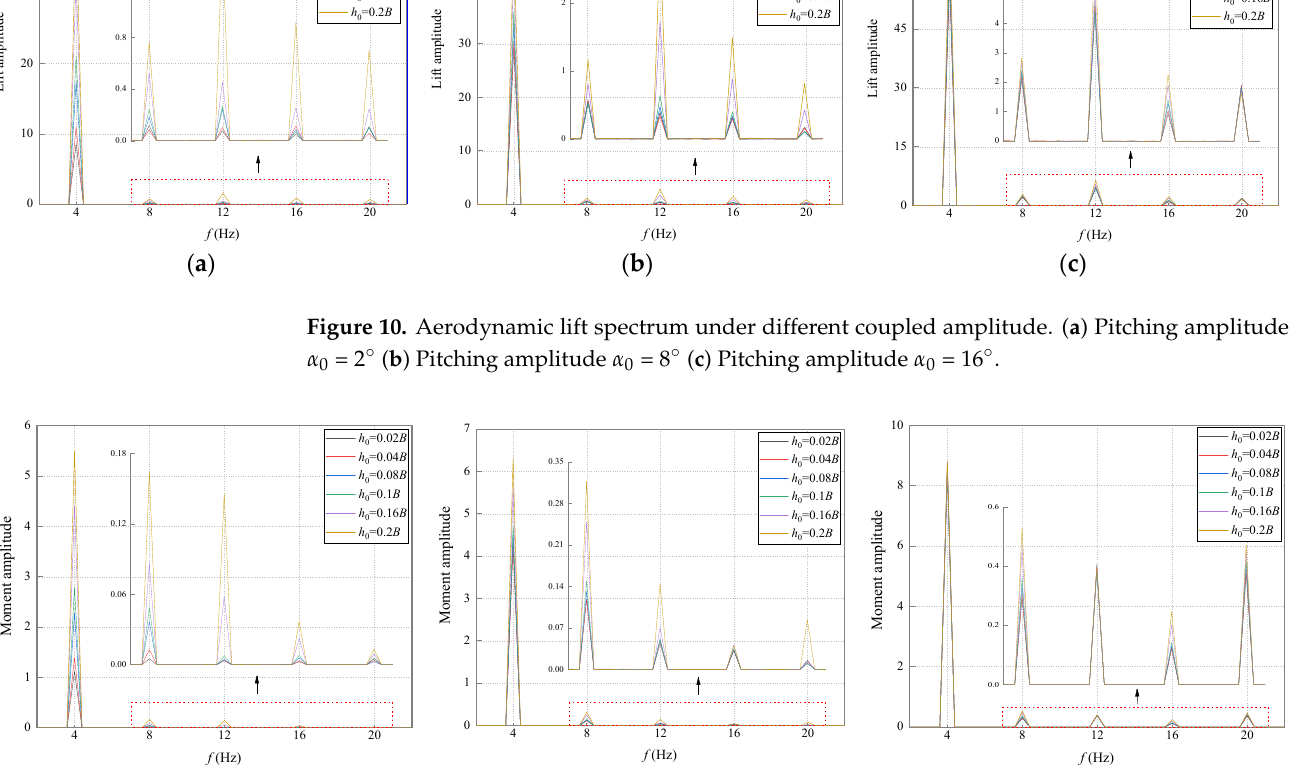
Figure 11. Aerodynamic moment spectrum under different coupled amplitude. ( a ) Pitching ampli- tude α 0 = 2° ( b ) Pitching amplitude α 0 = 8° ( c ) Pitching amplitude α 0 = 16°. Pitching motions with different amplitudes ( α 0 = 2°, 4°, 8°, 10°, 16°, 20°) are added to three groups of foundation heaving motions ( h 0 = 0.02 B , 0.1 B , 0.2 B) , and the spectrum diagram is shown in Figures 12 and 13. The main component of the aerodynamic lift and moment is transferred from the second harmonic to the third with the increase in the added pitching amplitude, and the pitching amplitude required for the energy transfer of the aerodynamic lift is smaller than moment. The increase in the foundational heaving amplitude can promote the energy transfer phenomenon of aerodynamic lift, but restrain the harmonic energy transfer of aerodynamic